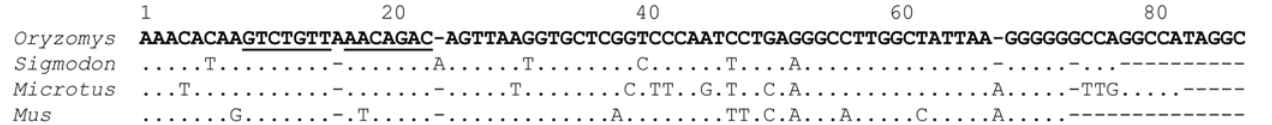
Figure 5. Alignment of the O. palustris G repeat region. The first monomer of the O. palustris G repeat, which is repeated four times, is shown in bold. It is aligned with the corresponding single copies in the other three species. Dashes indicate gaps. Periods indicate identity. The first group of 7 underlined bases is a highly conserved sequence separated by one base in O. palustris from an inverted copy (also underlined).